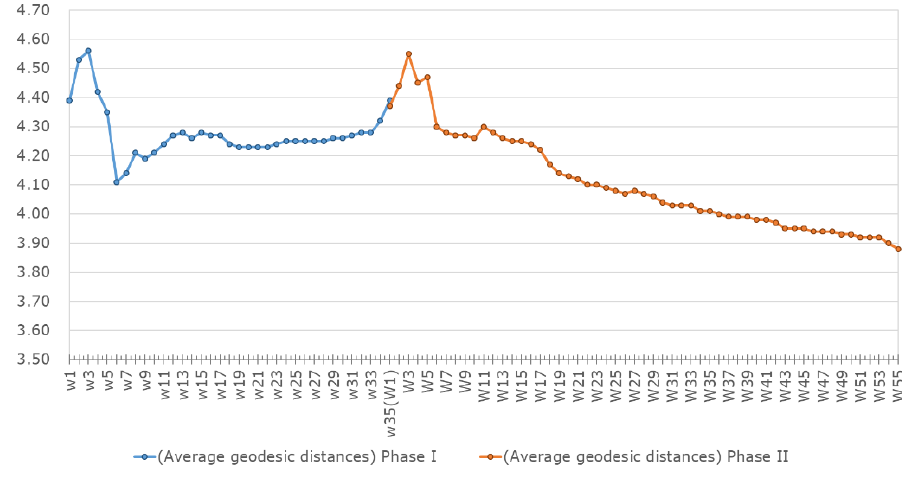
Figure 5. Average geodesic distances. Note: in the oriental axis, w i and W i are the labels for the time windows of Phase I and Phase II, respectively.